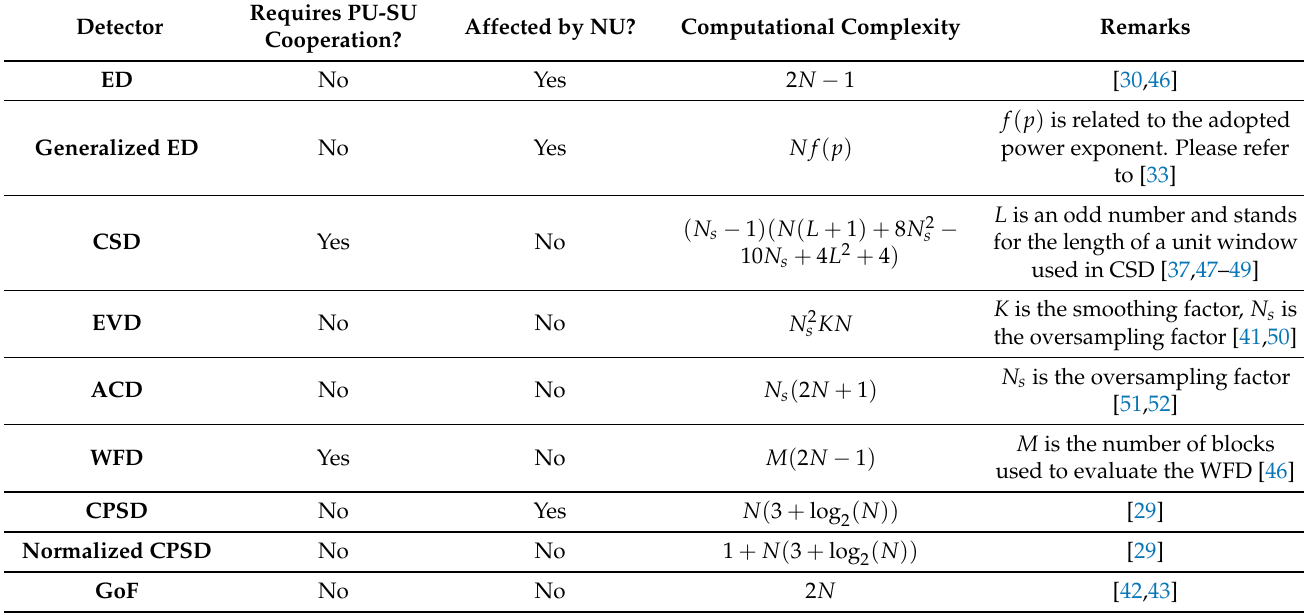
Table 2. Comparison among the widely used Spectrum Sensing detectors, with respect to: need for Secondary User (SU)–Primary User (PU) cooperation, the Noise Uncertainty (NU) effect, and the computational complexity, for a number of received samples N